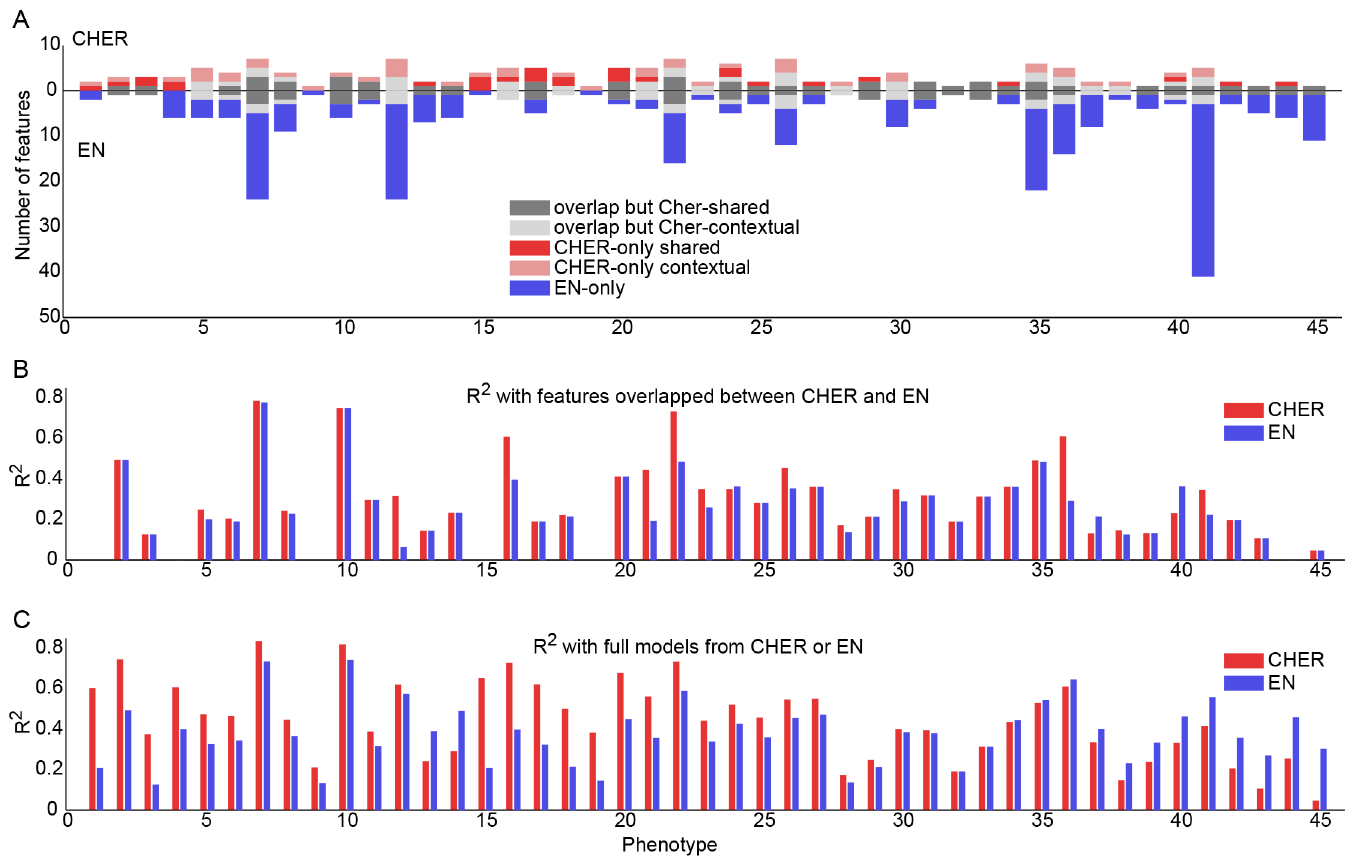
Fig 4. Comparison of features selected by CHER and elastic net (EN). A. Number of features selected by both and individual algorithms for each phenotype. For each phenotype (x-axis), numbers of features selected by CHER are represented on the positive y-axis whereas those selected by elastic net are represented on the negative y-axis. Features are separated into five groups, corresponding to features selected by both algorithms or by specific to individual algorithms. Phenotype 1 – 14 are from CCLE-SkinGlioma and the rest are from CCLE-Blood. B. Adjusted R 2 of CHER and elastic net models using the features selected by both algorithms (features of the first two categories in A). C. As B, but all features selected by each algorithm are used. Phenotypes in all three figures are sorted by the difference of R 2 between CHER and elastic net from C.